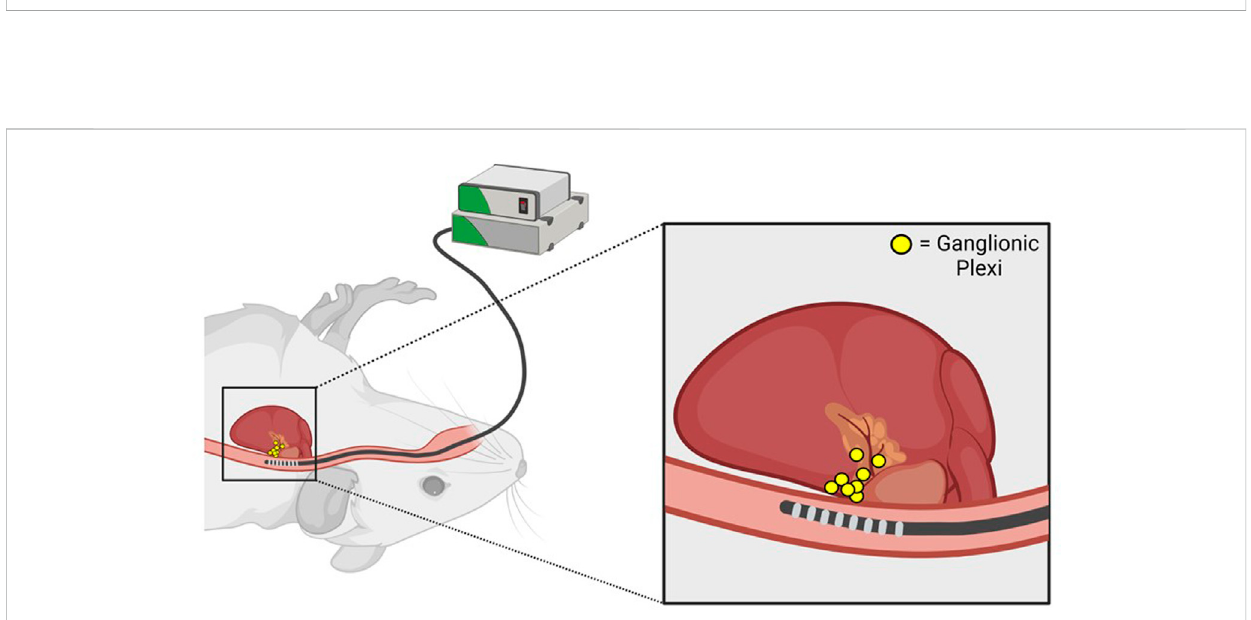
FIGURE 2 Anatomic basis for parasympathetic stimulation during transesophageal atrial pacing. Proximity of the transesophageal pacing catheter to posterior left atrial ganglionic plexi is illustrated. Adapted from Murphy MB, Kim K, Kannankeril PJ, Murray KT. Optimization of Transesophageal Atrial Pacing to Assess Atrial Fibrillation Susceptibility in Mice. J Vis Exp . (184), e64168, doi:10.3791/64168